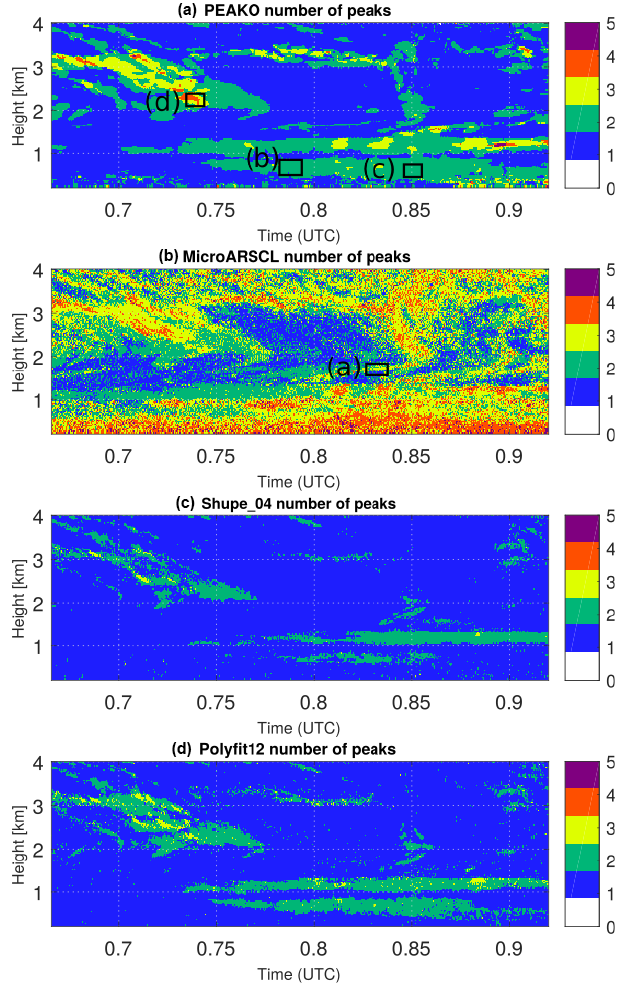
Figure A2. Like Fig. 5 but for 16 February 2014, 0.67–0.92UTC, at 0–4km